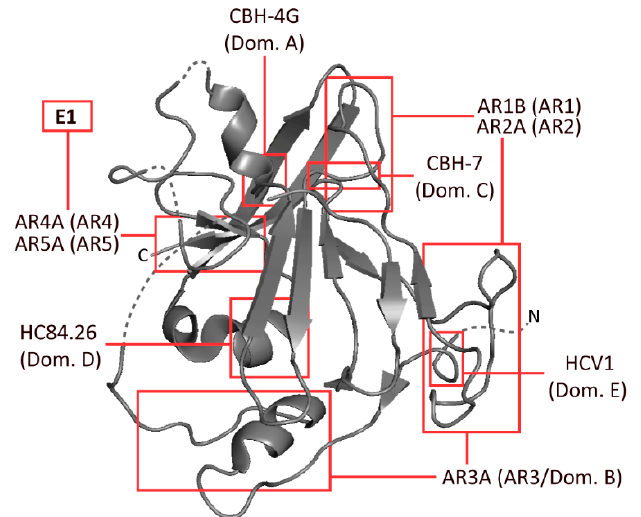
Figure 1. Schematic representation of HCV envelope protein E2, developed from the 2013 crystal structure of the protein by Kong et al. The approximate binding residues of nine mAbs covering a range of epitopes is shown. Structural information taken from the Protein Data Bank—accession code 4MWF [18].